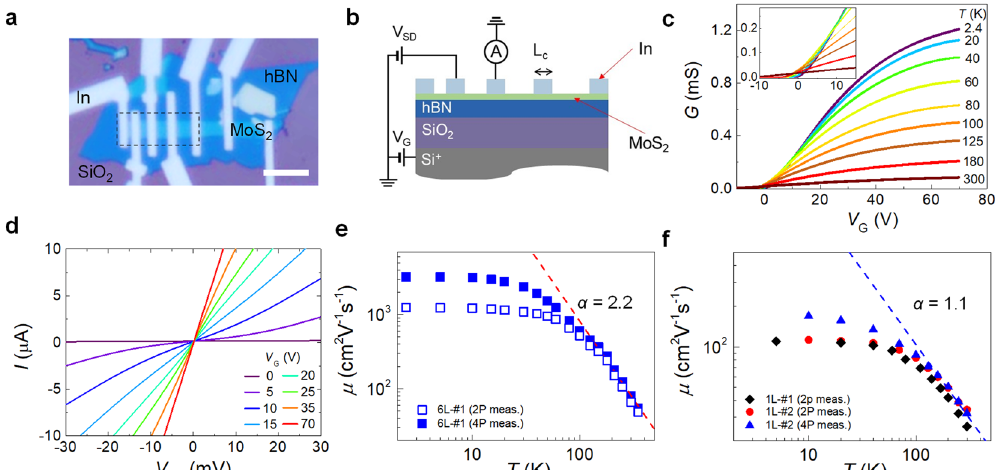
Fig. 4 Basic electrical properties of a few-layer MoS 2 fi eld-effect transistor. a Optical image of a 6L-#1 MoS 2 device with multiple In contacts. Scale bar: 5 μ m. b Schematic of 6L-#1 MoS 2 device for the transfer length method (TLM). Here, L c ( = 1 μ m) is the length of contact electrode. The measurement scheme shows the two-probe measurement for the L 2 = 1 μ m channel. c Conductance ( G ) as a function of the back-gate voltage ( V G ) at various temperatures. Inset: G – V G curves near the metal – insulator crossover region. d I – V SD curves for various V G at T = 2.4 K. e , f Mobility ( μ ) as a function of temperature ( T ) in log scale for 6L and 1L devices, respectively. The red and blue dashed lines in e and f are fi tting lines with the relation of μ T ð Þ / T (cid:3) α with α = 2.2 and 1.1 for 6L and 1L devices,